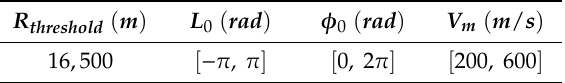
Table 1. Initial conditions of the homing phase.